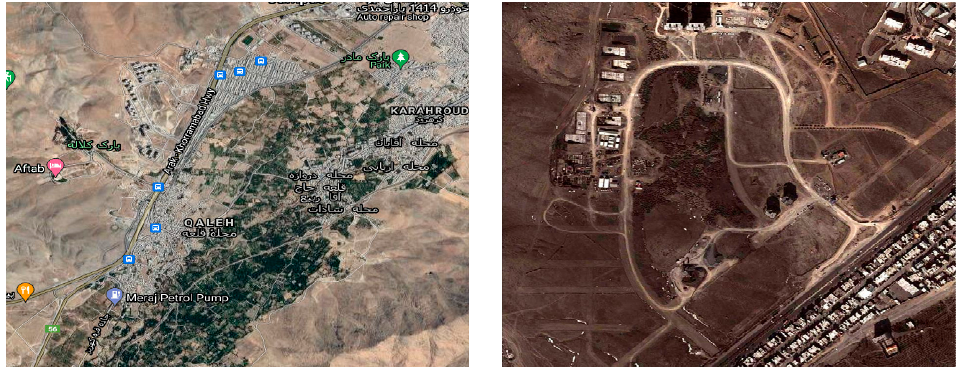
Figure 1. Aerial map of the study area in the Sanjan Plain. Right image of northern lands with residential use. Left image with agricultural use in the southern part.